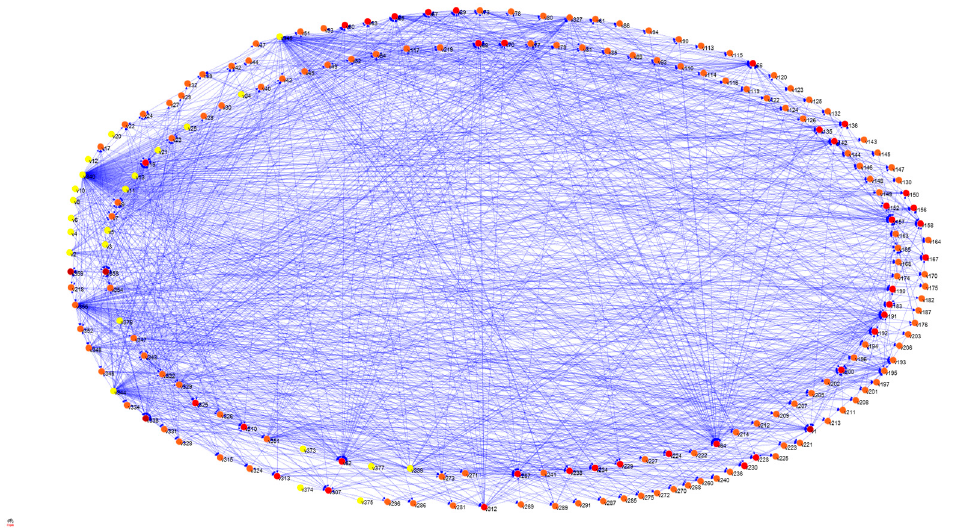
Figure 3. Propagation process of reclamation risk in the tailings ponds.